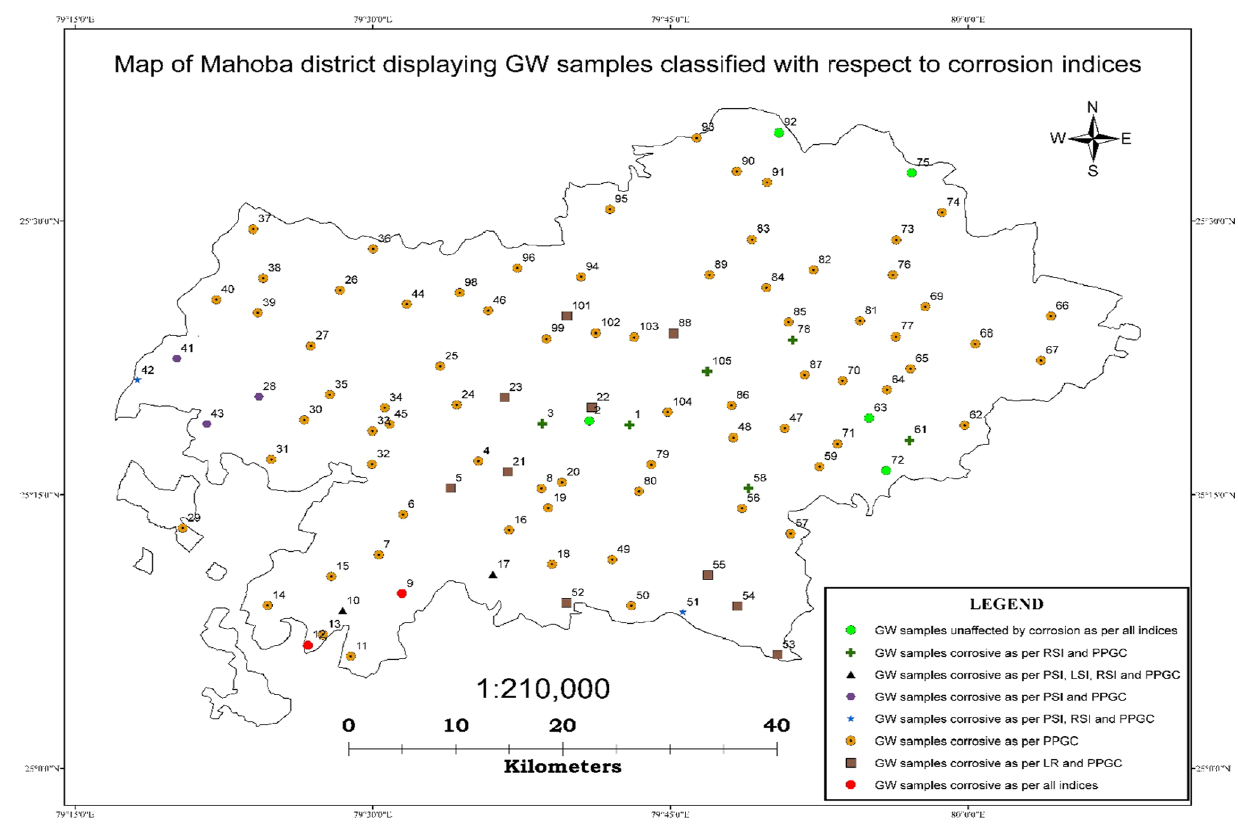
Fig. 5 Map displaying GW sampling locations classified with respect to various corrosion